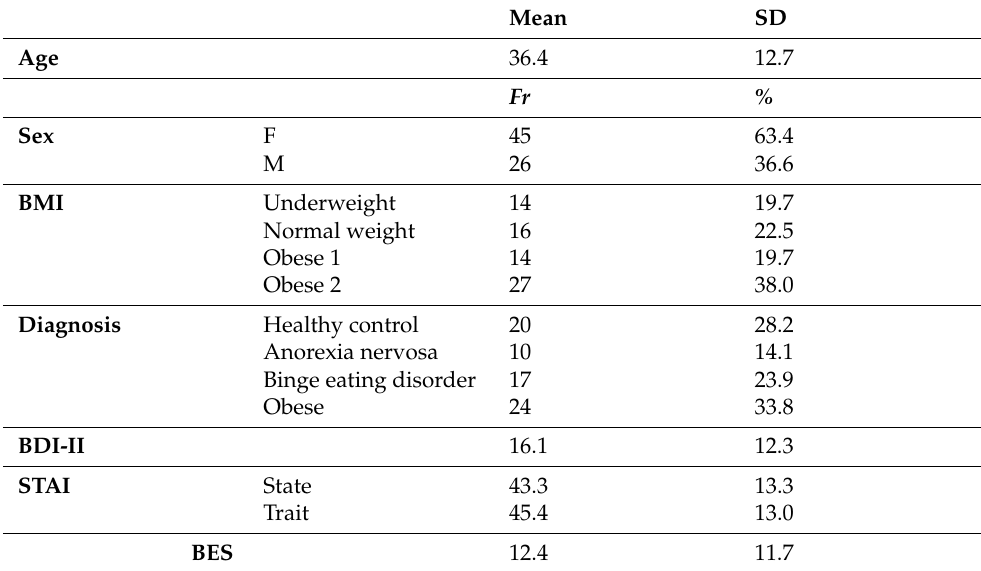
Table 1. Sample description and psychopathological tests.